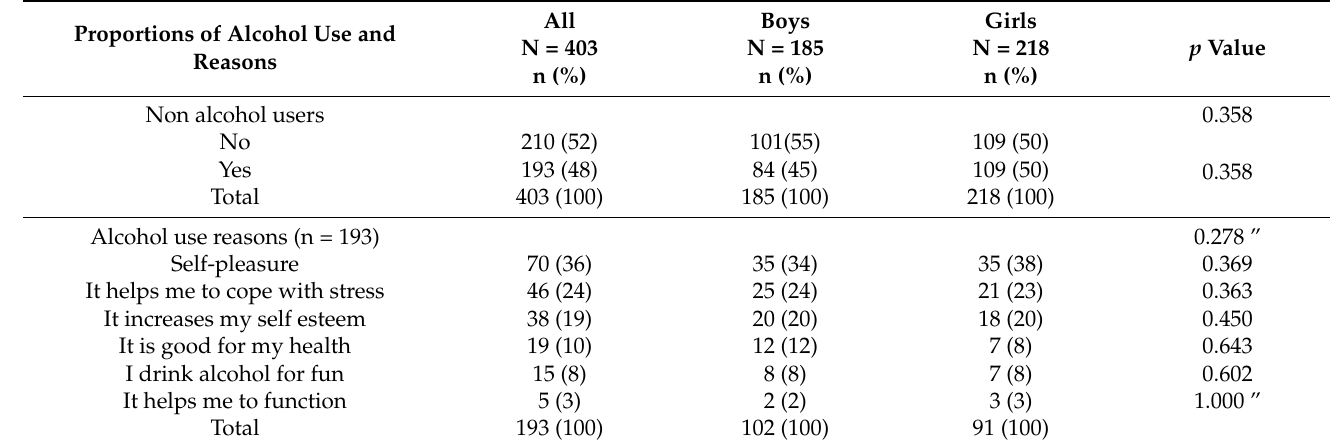
Table 3. Motivations for alcohol use among the school learners, n = 194.